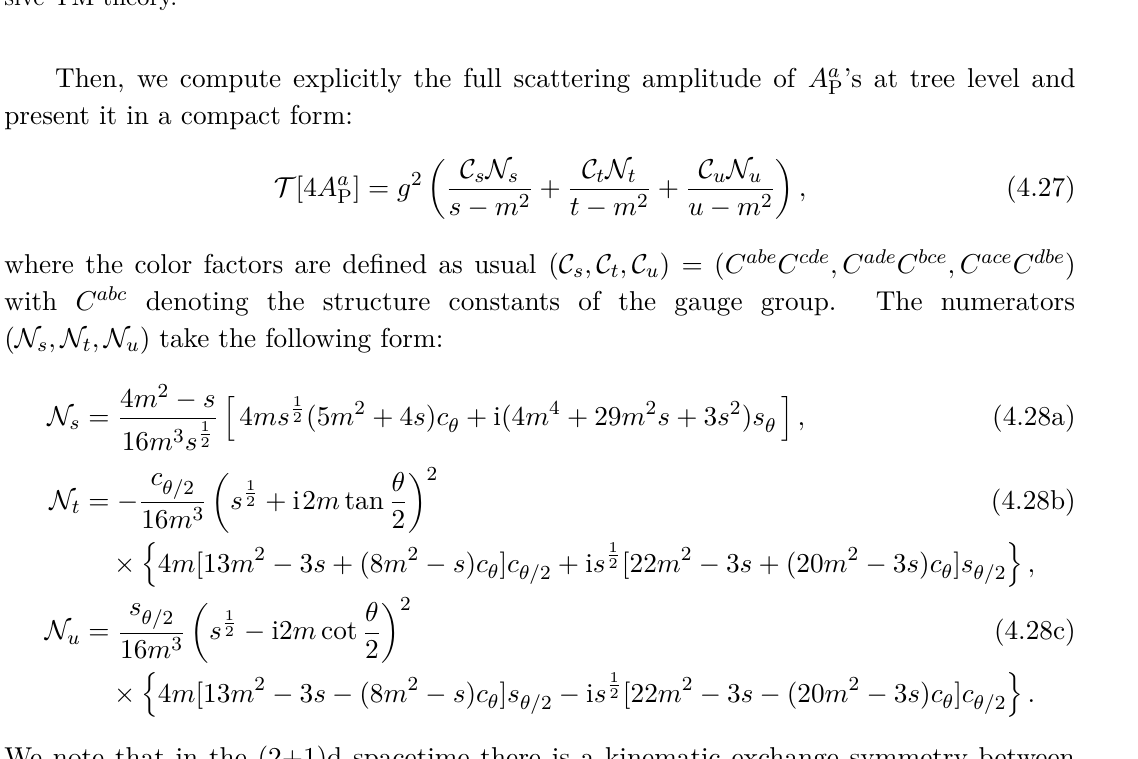
Figure 4 . Feynman diagrams of the four-gauge boson scattering processes A a and A a A b → A c A d via the contact interaction and ( s, t, u ) -channels in 3d topologically mas- T T T T sive YM